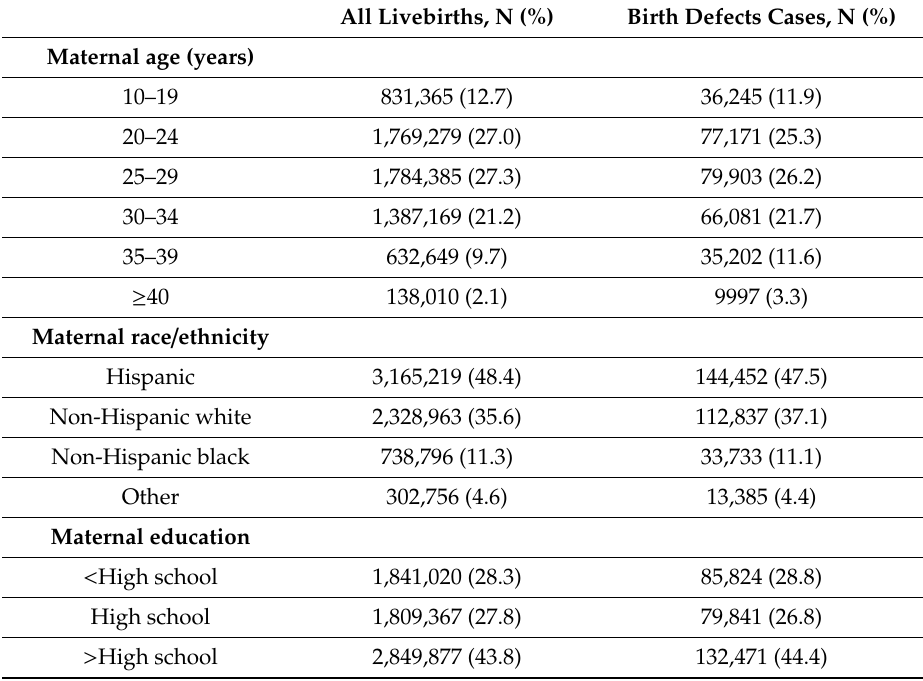
Table 1. Demographic characteristics of livebirths and birth defects cases in Texas, 1999–2015.